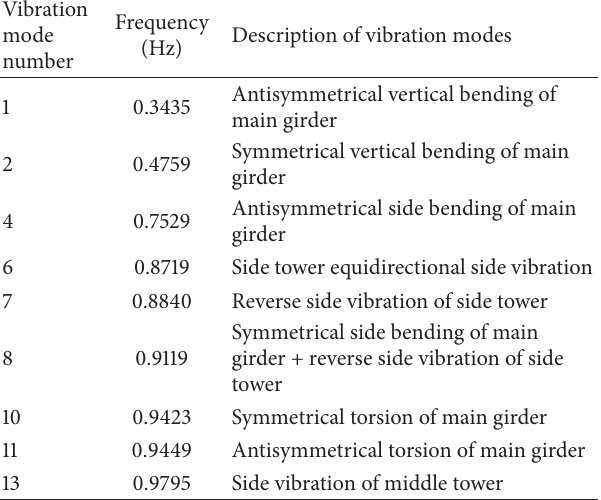
Table 1: Natural vibration frequencies and vibration modes descrip- tion of primary vibration modes of the